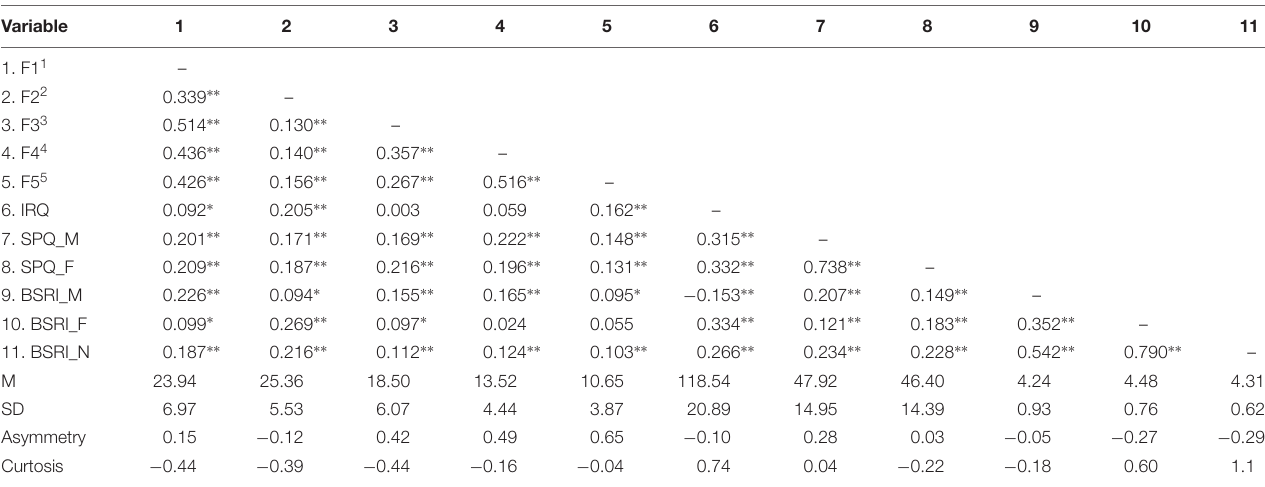
TABLE 1 | Pearson correlations between the study variables and total scores (mean, ds, asymmetry, and kurtosis).